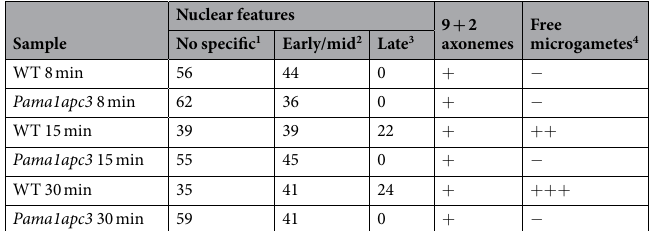
Table 1. Quantitation of the ultrastructural features of wild type and mutant parasites based on stage of microgametocyte development. Nuclear features observed by electron microscopy at 8, 15 and 30 mpa based on the examination of 100 microgametocytes identified by axonemes at each time point. The stage identified were nuclei with: 1 No specific features in the plane of section. 2 Early/mid stage with nuclei with nuclear poles and spindle microtubules with attach kinetochores. 3 Late stage with the nucleus exhibiting areas of condensed chromatin. 4 No free microgametes were observed in the mutant at any time point while increased numbers were observed between 15 and 30 mpa in the wild